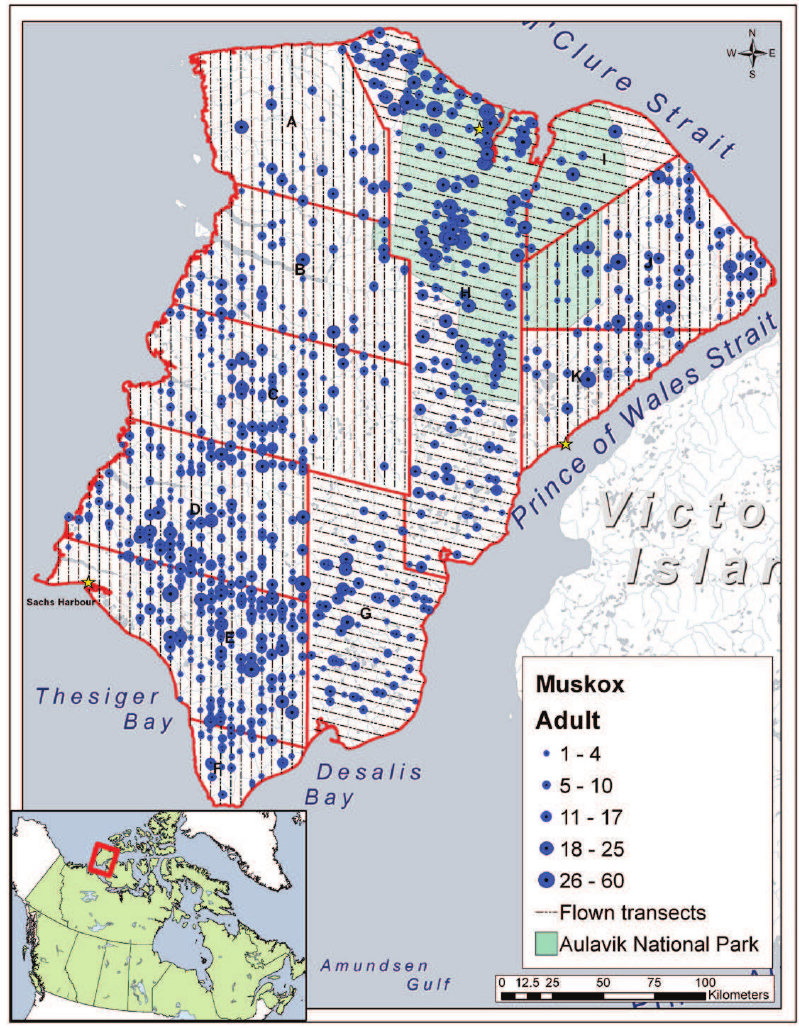
Fig. 3: Population counts of adult Minto Inlet Peary caribou and Dolphin- Union caribou on northwest Banks Island, NWT with 95% confidence inter- vals around the population estimates.